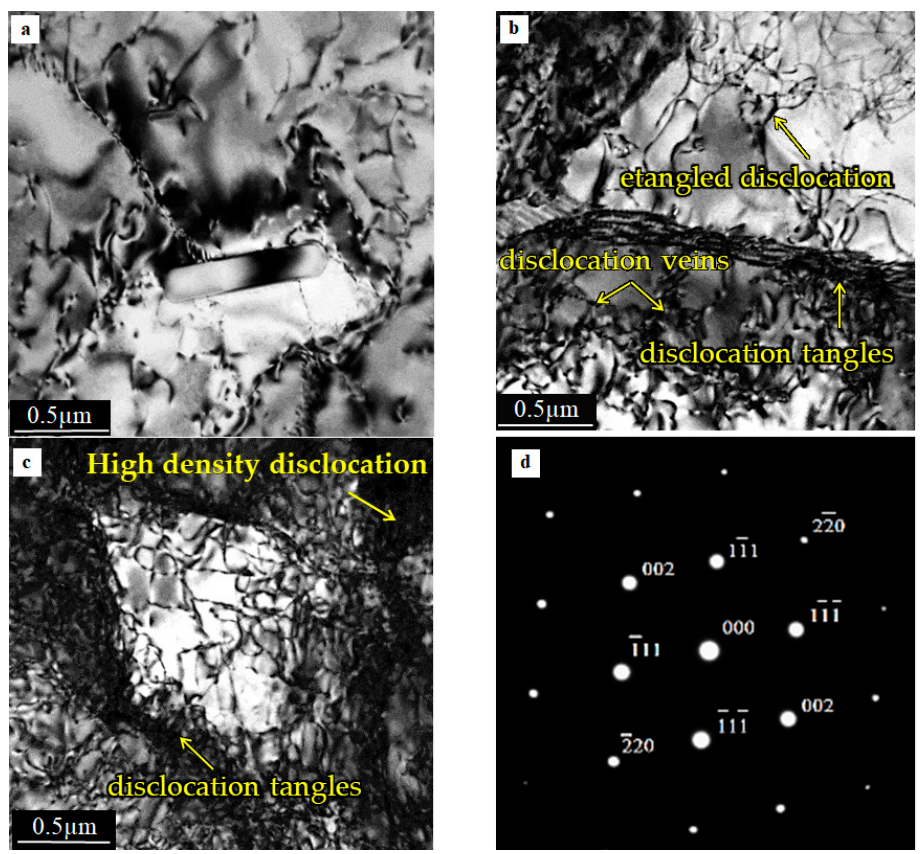
Figure 12. Micrograph showing microstructure in aluminum alloy friction weld at a distance 10 mm from the interface ( a – c ), ( d ) SAD from dark grain showed in Figure